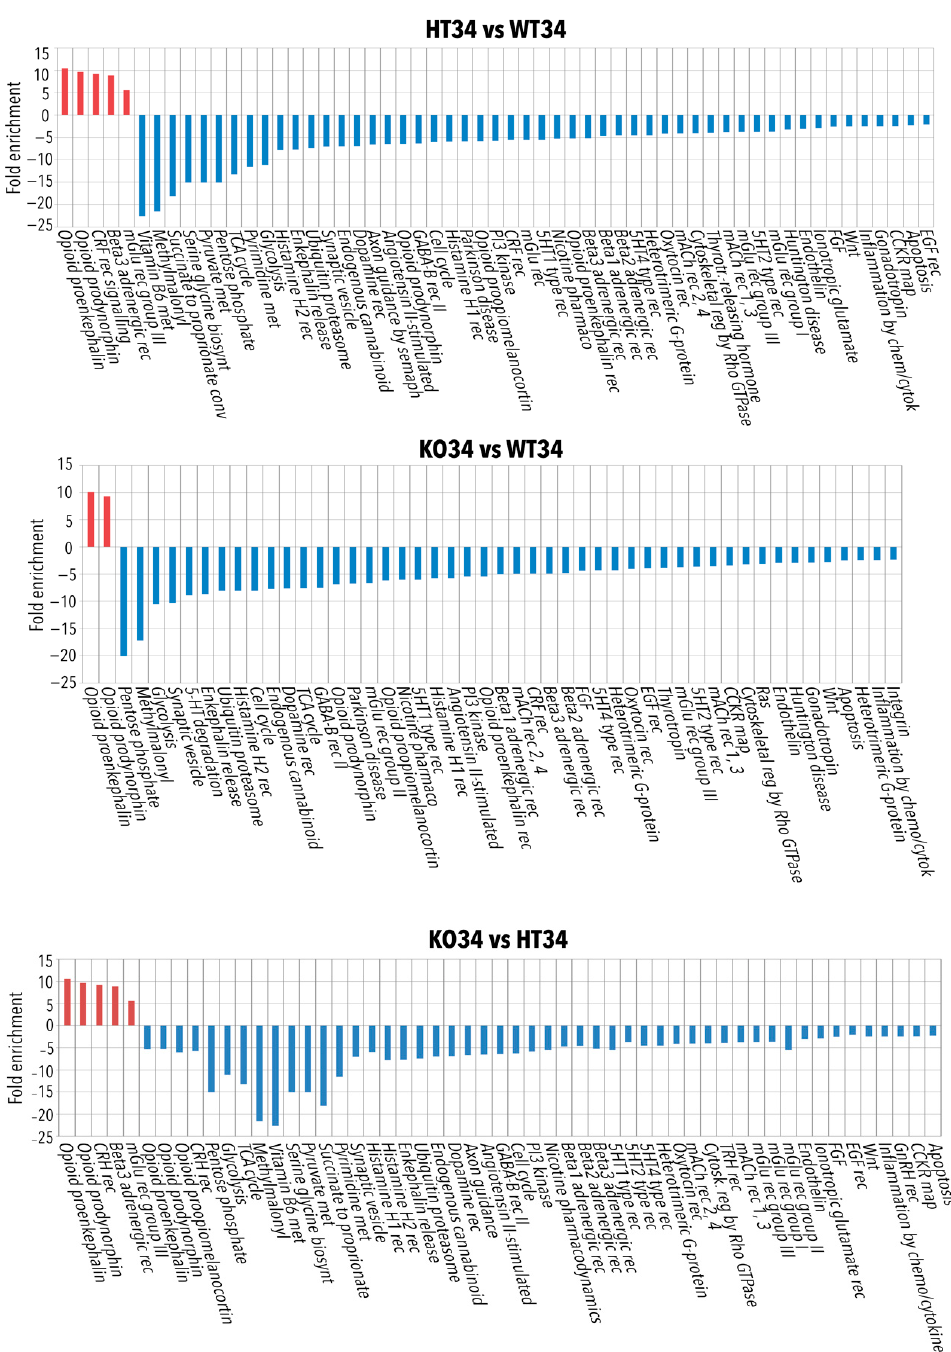
Figure 6. Panther pathways analysis of the proteins differentially or exclusively expressed in HT34 vs. WT34, KO34 vs. WT34 and KO34 vs. HT34. Bioinformatic analyses were conducted by Panther software (release 16.0) to cluster enriched Panther pathway within the set of differentially expressed or exclusively expressed proteins in HT34 vs. WT34, KO34 vs. WT34 and KO34 vs. HT34. If any Panther pathways enrichment was found, the data were processed by Panther Reactome to find Reactome GO and pathways enrichment. Functional grouping was based on Fischer’s exact test p ≤ 0.05 and at least three counts.